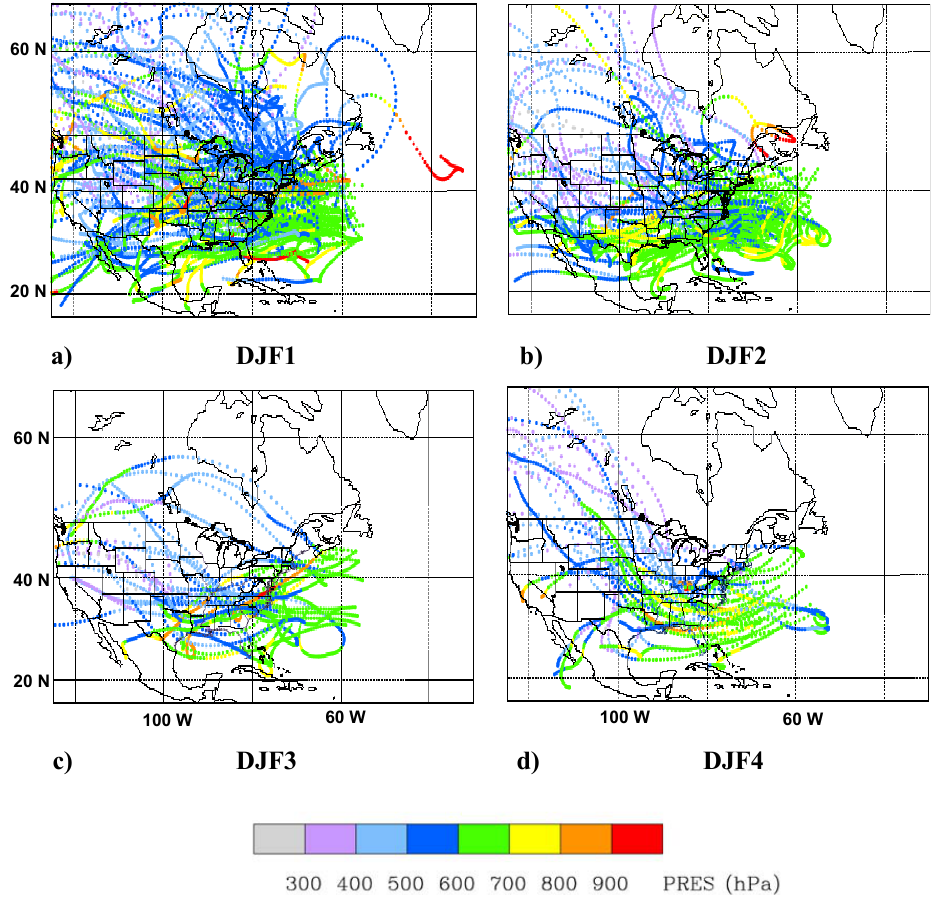
Fig. 5. Four-day HYSPLIT back trajectories using GDAS 1 ◦ X 1 ◦ data from locations of TES 681hPa observations in Region 1 for map types DJF1-DJF4 (a-d) . The colors indicate the altitudes of the trajectories in pressure